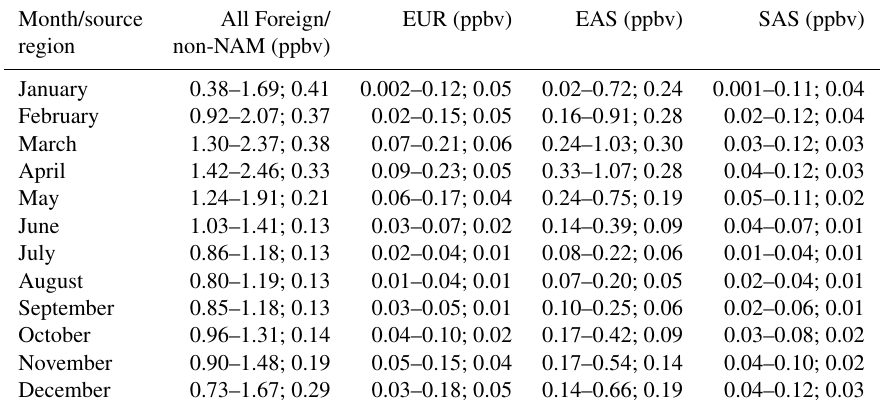
Table 4. The ranges and standard deviations (ppbv, separated by “;”) of R (O 3 , [source region], 20%) by 6–8 global models (defined in Eqs. 1a–1d), summarized by months in 2010. The monthly multi-model mean values are shown in Figs.